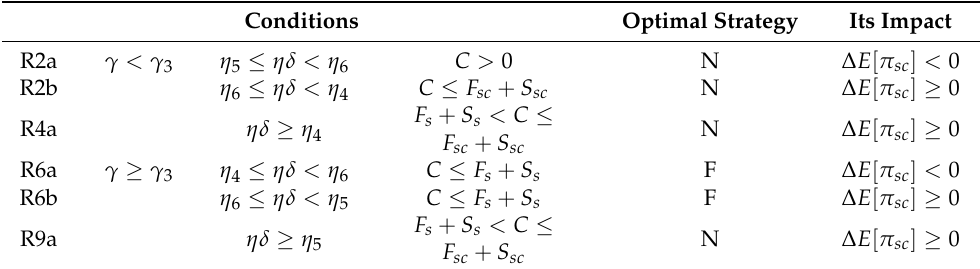
Table 3. The impact of the optimal strategy on the whole supply